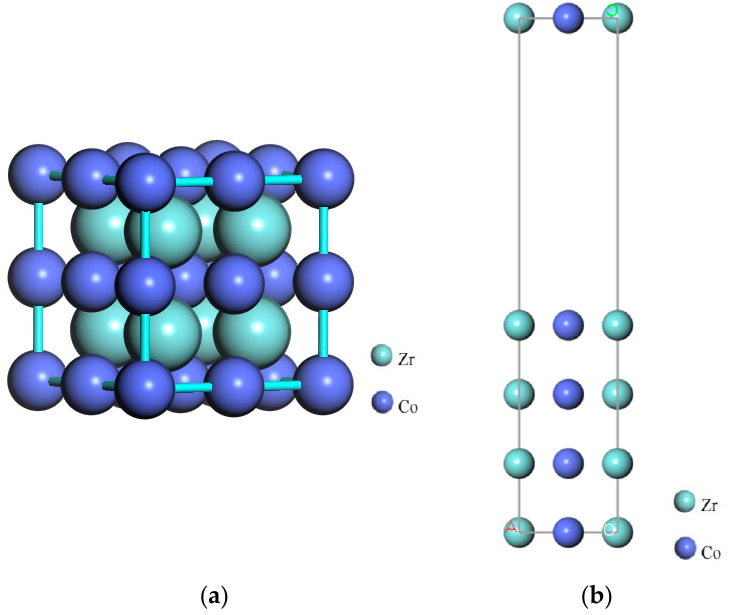
Figure 2. Crystal structures of the ( a ) conventional model and ( b ) surface adsorption